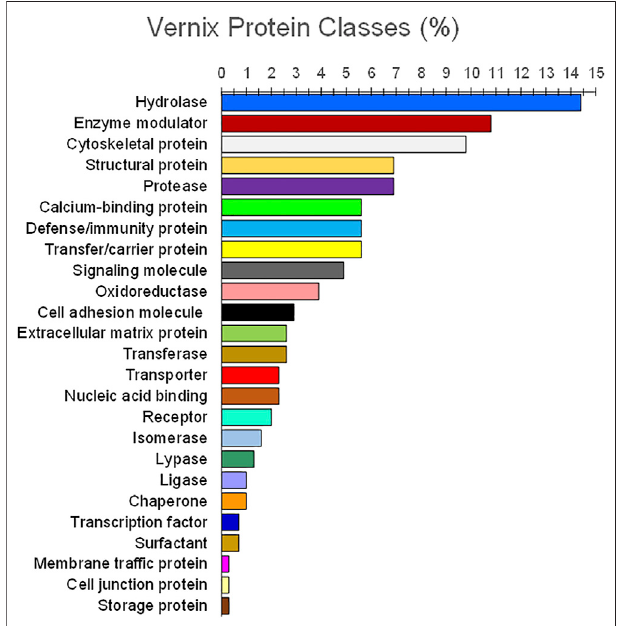
FIGURE 2 | Functional classes of vernix proteins. Vernix was extracted and digested with trypsin, quanti fi ed by liquid chromatography – tandem mass spectrometry, and analyzed against the Swiss-Prot protein database (Holm et al., 2014). Proteins ( n = 203) for p < 0.05 and belonging to 25 functional classes were identi fi ed (percent by weight). Hydrolases, proteases, and enzyme modulators encompassed 29, 22, and 22 proteins, respectively, with 11 proteins classi fi ed as